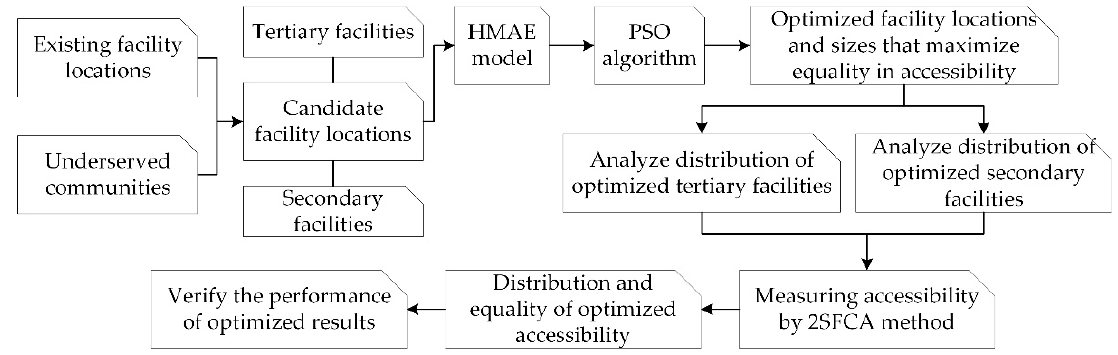
Figure 2. The framework of the procedures in this study.